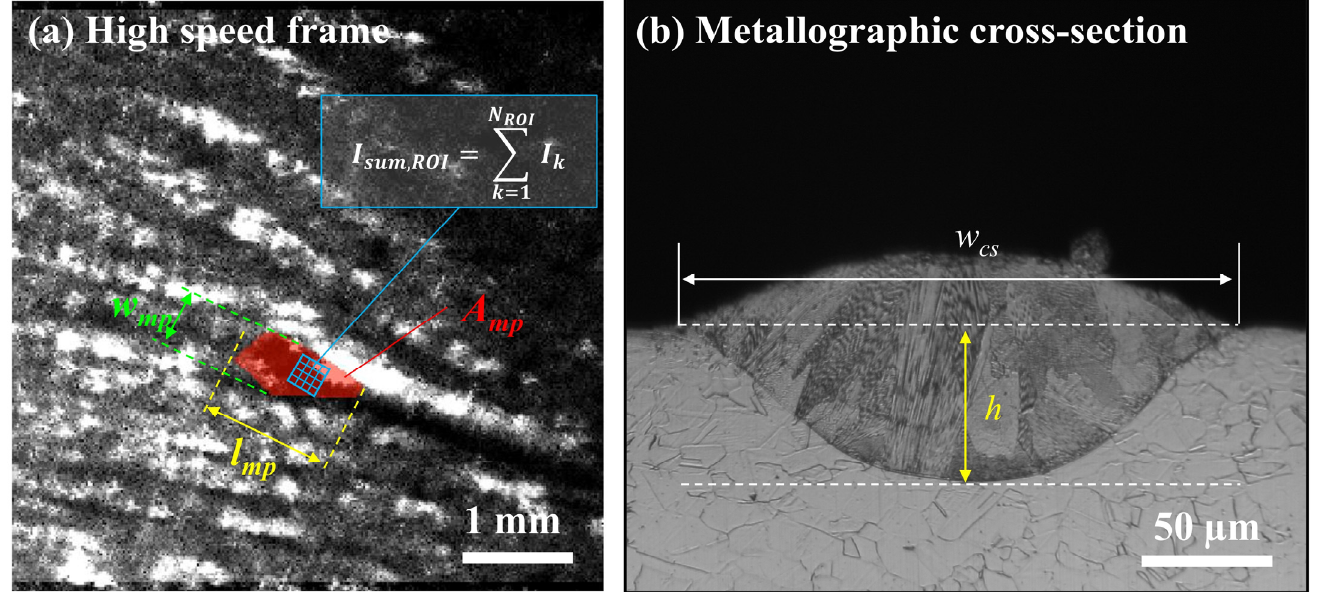
Figure 4. Schematisation of the principal parameters acquired to characterise the geometrical features of the melt: ( a ) width ( w mp ), length ( l mp ), area ( A mp ) and oscillation indicator I sum,RO I and ( b ) metallographic cross-section indicating the penetration depth h and width w cs .